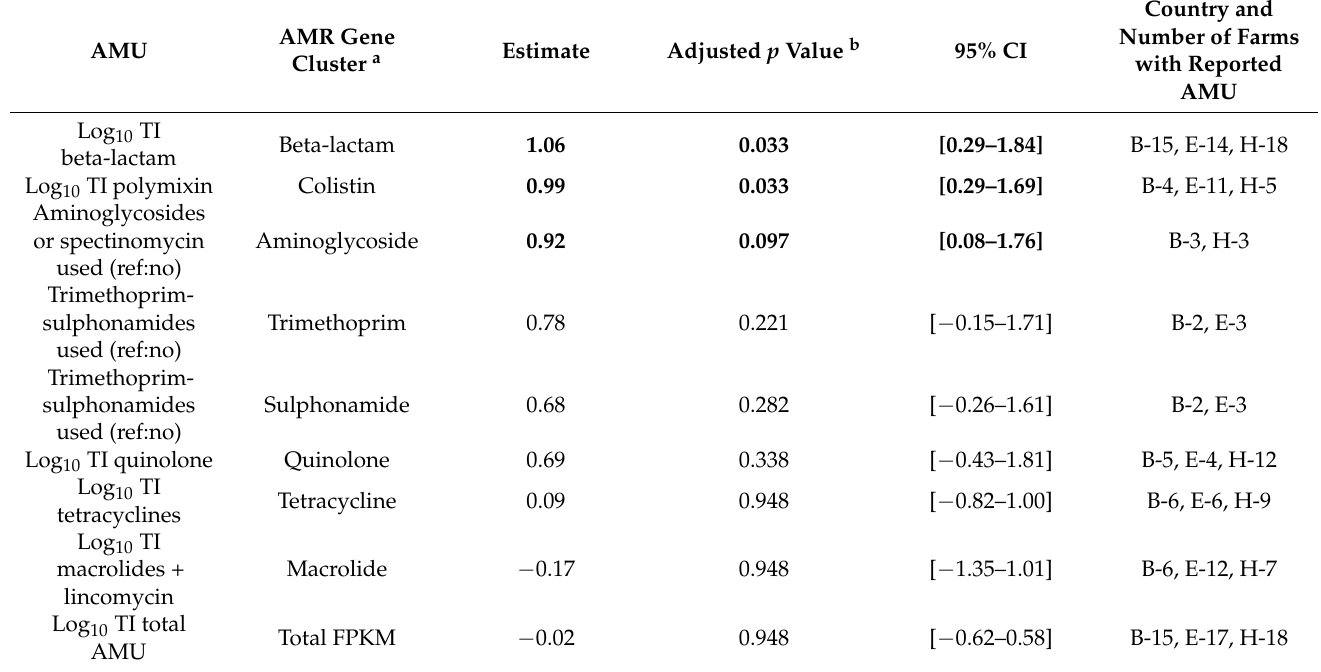
Table 2. Associations between antimicrobial usage (AMU) and relative abundance of the corresponding antimicrobial resistance (AMR) genes detected by metagenomics, obtained from a random-effects meta-analysis by